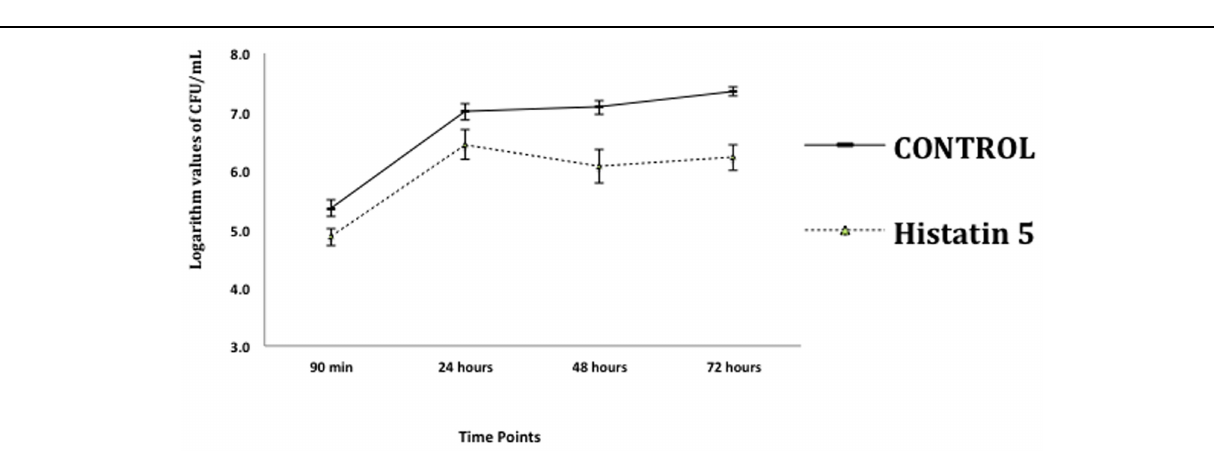
FIGURE 2 | Logarithm values of CFU/mL − 1 when histatin 5, in a concentration of 15 µ g/mL, is adsorpted on a microtiter plate prior to C. albicans biofilm formation in different stages of growth: 90 min, 24, 48 and 72 h, and their respective controls.